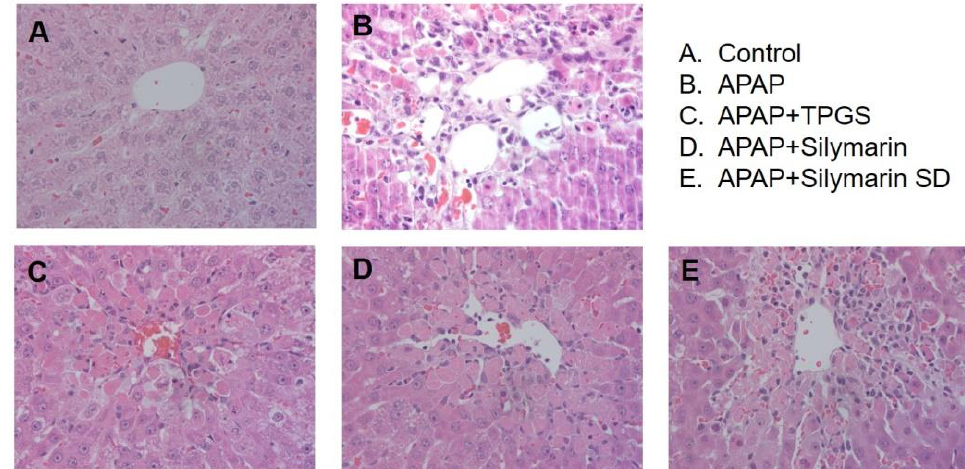
Figure 8. Representative liver histopathology hematoxylin and eosin (400×) images. The effect of silymarin-TPGS on APAP-induced hepatotoxicity in rats. ( A ) Control rats, ( B ) acetaminophen